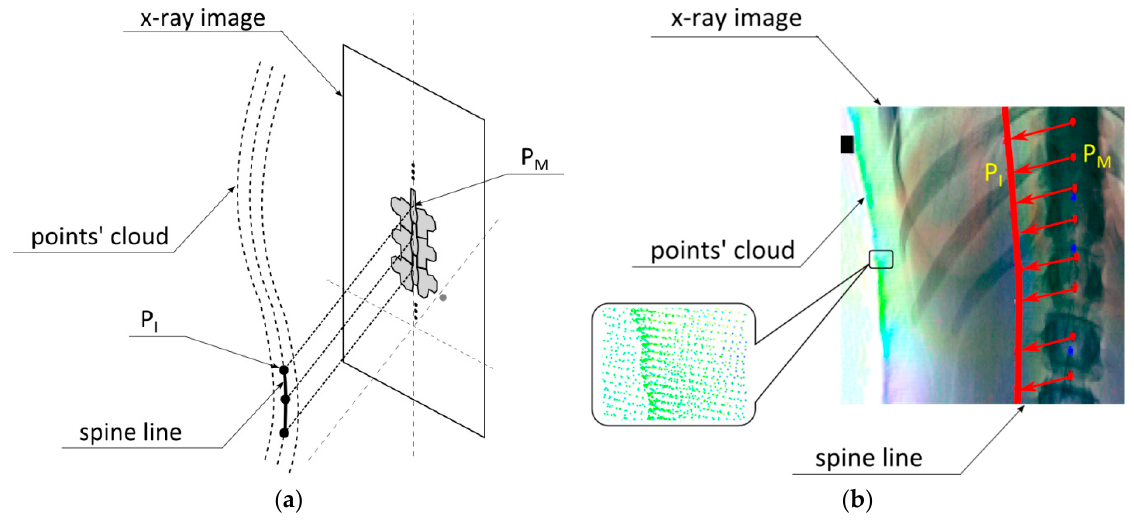
Figure 5. The projection for assigning the middle line of spine markers from an X-ray image onto an adjusted image of the cloud of points. ( a ) The presentation of the concept of merging a 3D ST structured light image with the radiogram. P M —a single marked point, P I —the projection of the point P M onto the point cloud ( b ) An example of merging in a real case.